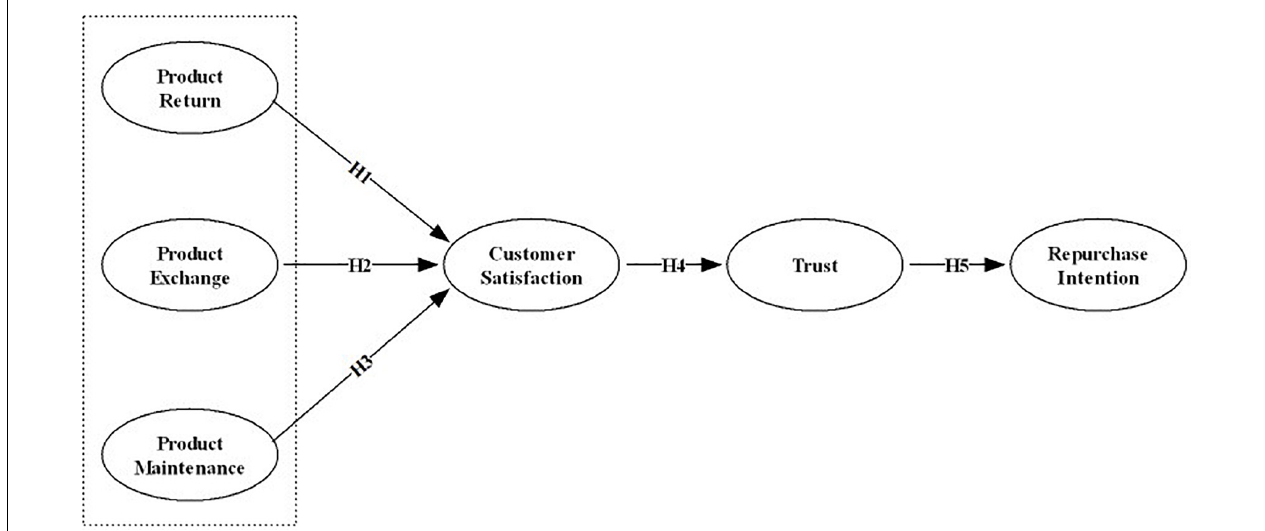
FIGURE 1 | Hypothesized